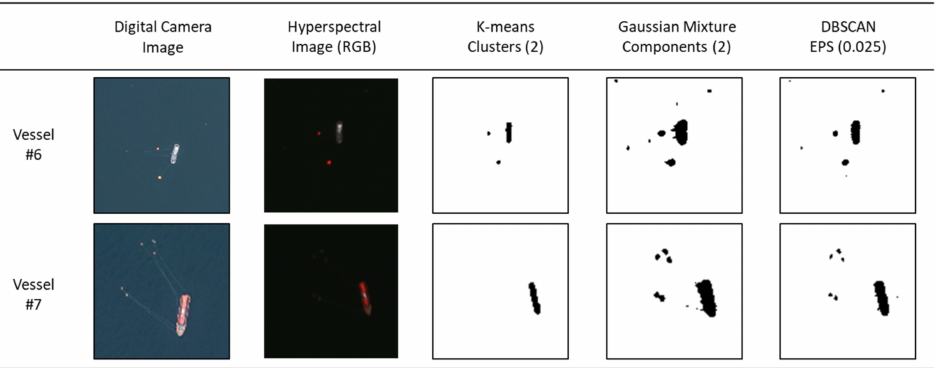
Figure 7. Detection performance analysis of small objects on seawater using a clustering algorithm. The detection performance of two target vessels in the sea and small objects overboard was analyzed using clustering algorithms. In the target of #6, the vessel, buoyant apparatus, life-raft, and dummies in the standing position, and in the target of #7, the vessel, lifebuoys, and dummies in the supine position, are connected with ropes and placed overboard with a certain distance between them. Ultra-high-resolution DMC images and hyperspectral RGB images were added to facilitate intuitive viewing and checking of the detection results for each